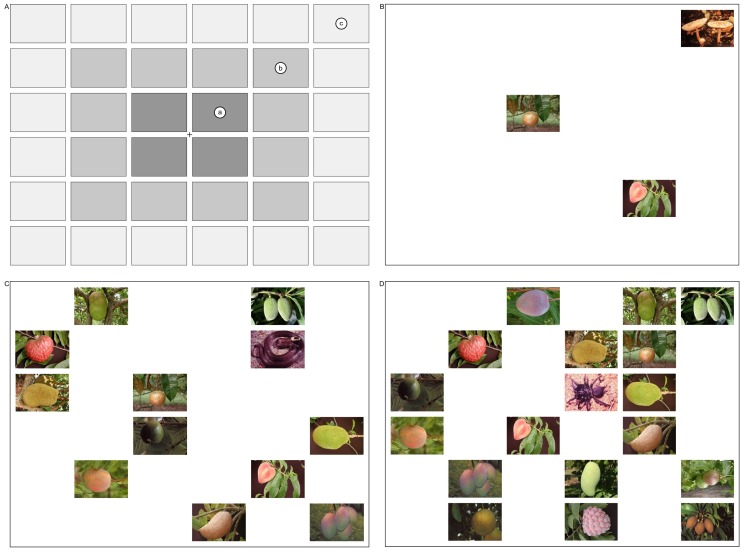
The visual display in Exp. 2 was presented in a grid, with the pictures arranged on an imaginary rectangle that was divided into a 6×6 grid (i.e., 36 cells).Upper left: Arrangement of the images in the display in the four foveal locations (A), twelve parafoveal locations (B), and twenty peripheral locations (C) (1.2°, 3.4°, and 5.7°, respectively) in Exp.2. Upper right: Example of a display with 3 items and a target picture (mushroom) in the periphery. Bottom left: Example of a display with 12 items and a target picture (snake) in the parafovea. Bottom right: Example of a display with 18 items and the target picture (spider) in the fovea.